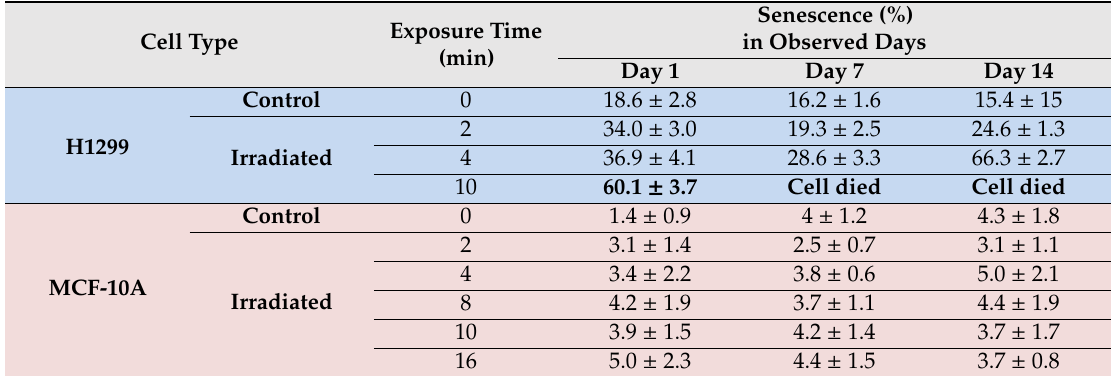
Table 6. Summary of the senescence e ff ect following W-band (75–105 GHz) MMW treatment on H1299 and MCF-10A cell